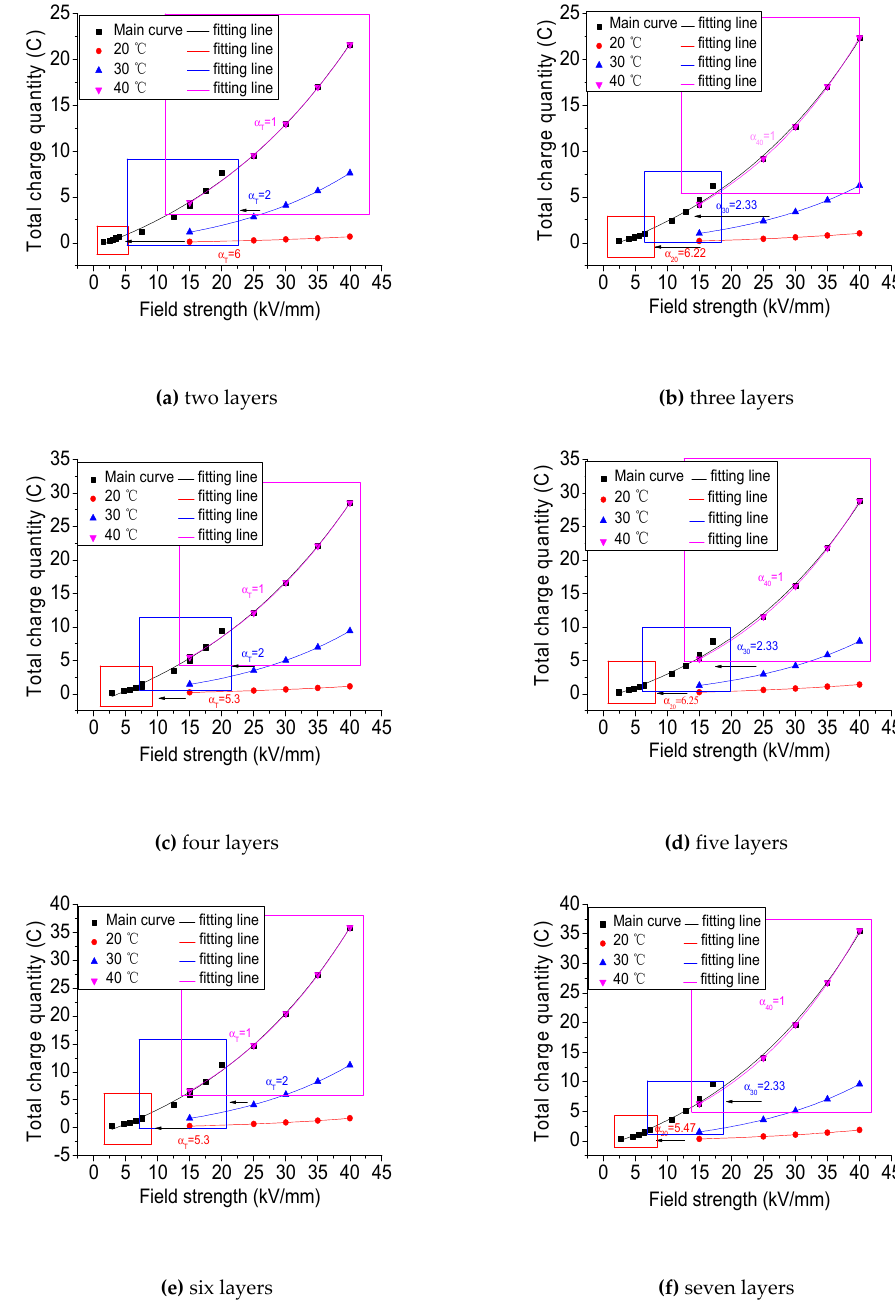
Figure 14. Total charge quantity at steady state under different electrical field strengths with different temperatures for multi-layer oil-paper insulation. Table 7. Calculation equations for the total charge quantity under the combined action of electrical field strength and temperature for multi-layer oil-paper insulation.